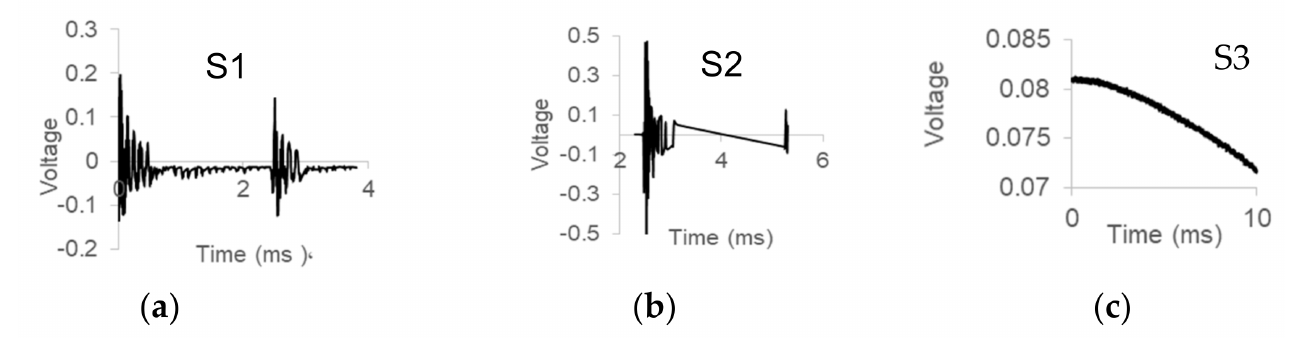
Figure 13. A typical IE signals ( a ) multiple peaks in sound set, ( b ) two peaks in sound set, ( c ) unusual